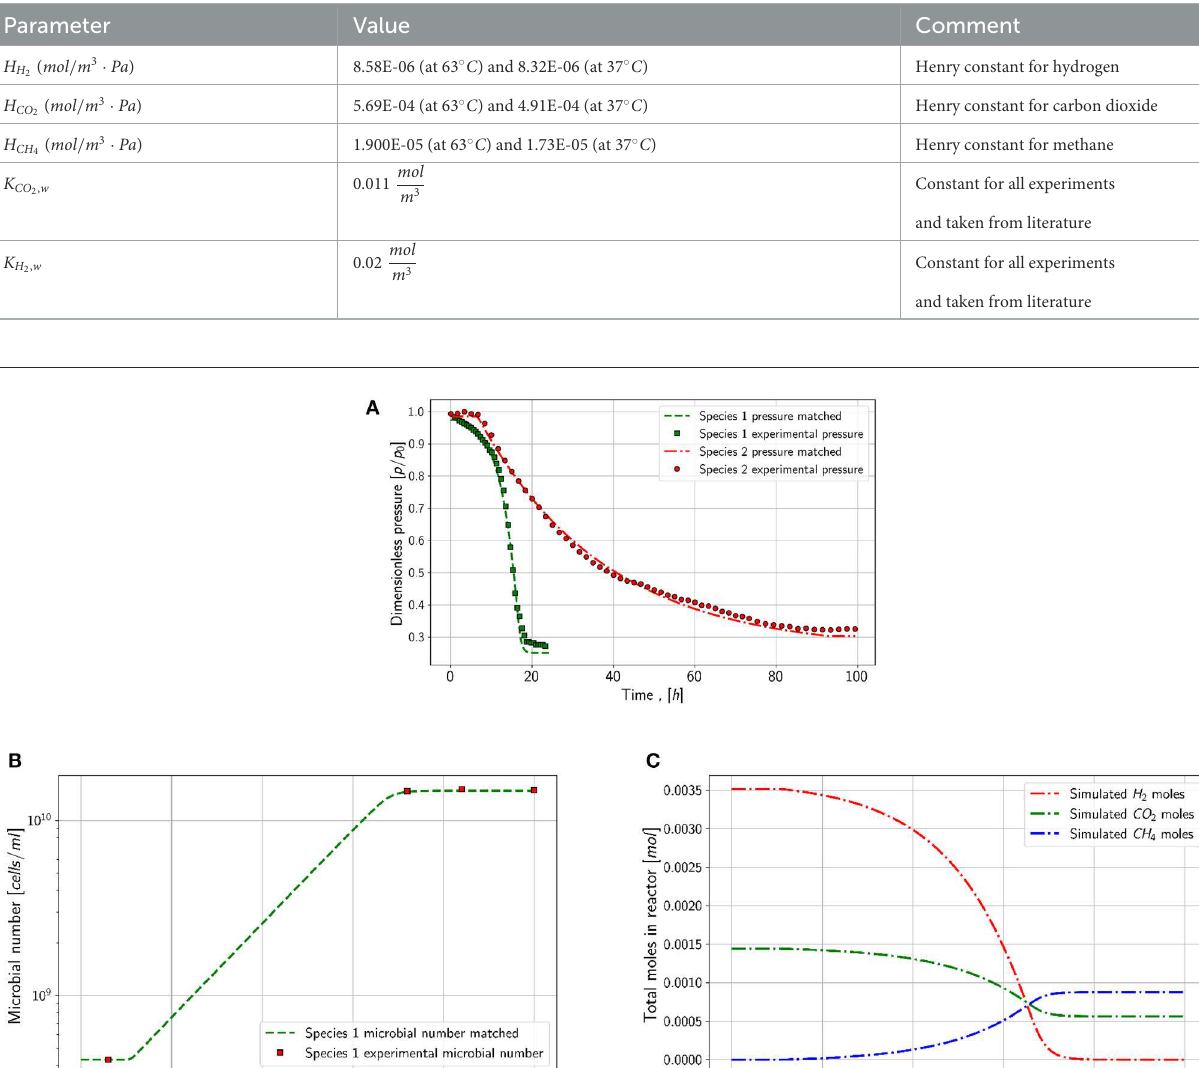
TABLE 2 Overview of the constant parameter for the simulation.